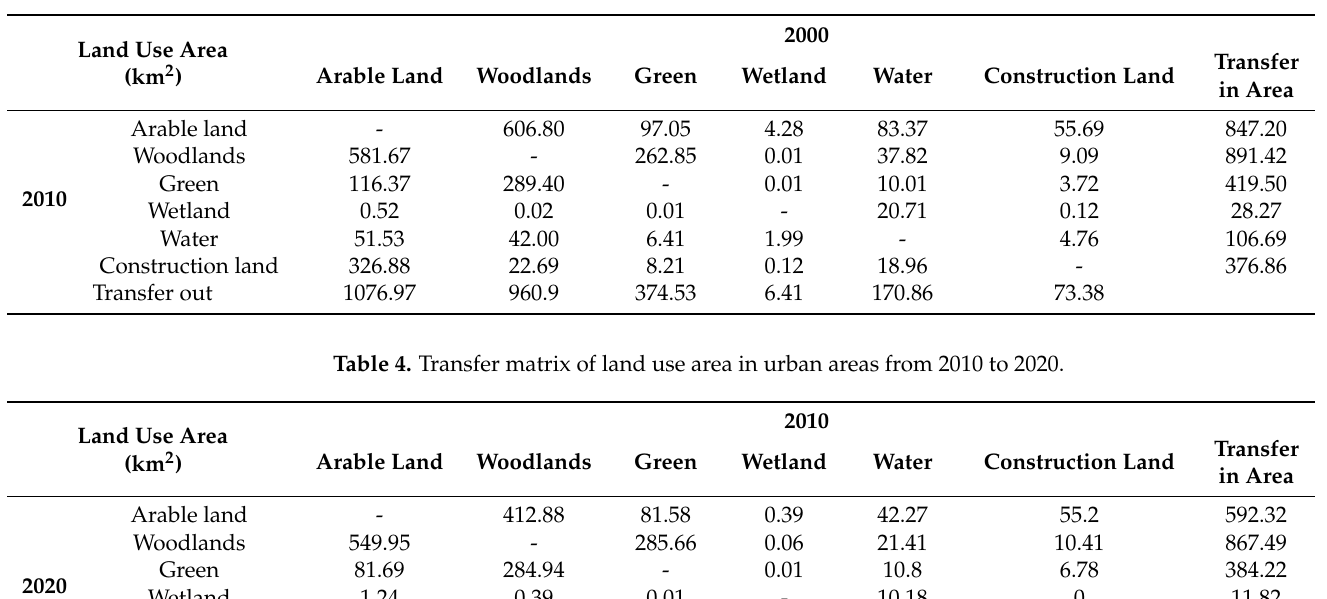
Table 3. Transfer matrix of land use area in urban areas from 2000 to 2010.